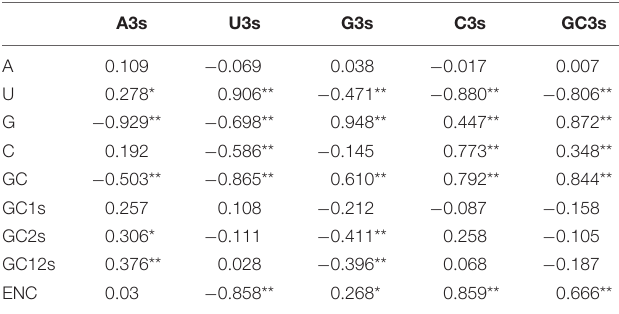
TABLE 3 | Correlation analysis between the codon compositions (A3s, U3s, G3s, C3s, and GC3s), the ENC values, nucleotide compositions (A%, U%, G%, C%, and GC%) of the 56 PEDV strains.